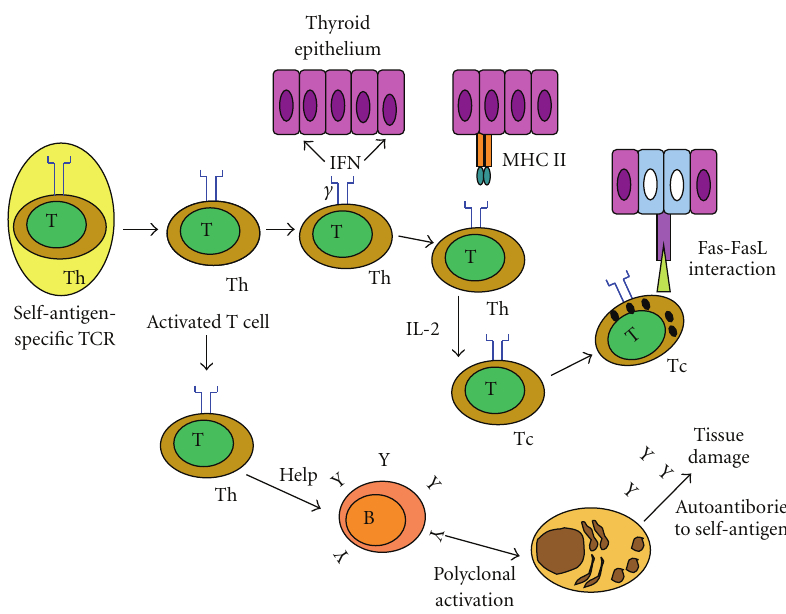
Figure 1: Activation of a self-specific T-cell initiates a cascade of events that amplifies the immune response and involves both CD4 and CD8 T cells, inducing an antibody-mediated response. B: B cells; IFN- γ : interferon- γ ; IL-2: interleukin-2; MHCII: major histocompatibility class II; T: T cells; Tc: cytotoxic T-cell; Th: T helper cell (adapted from [51]).